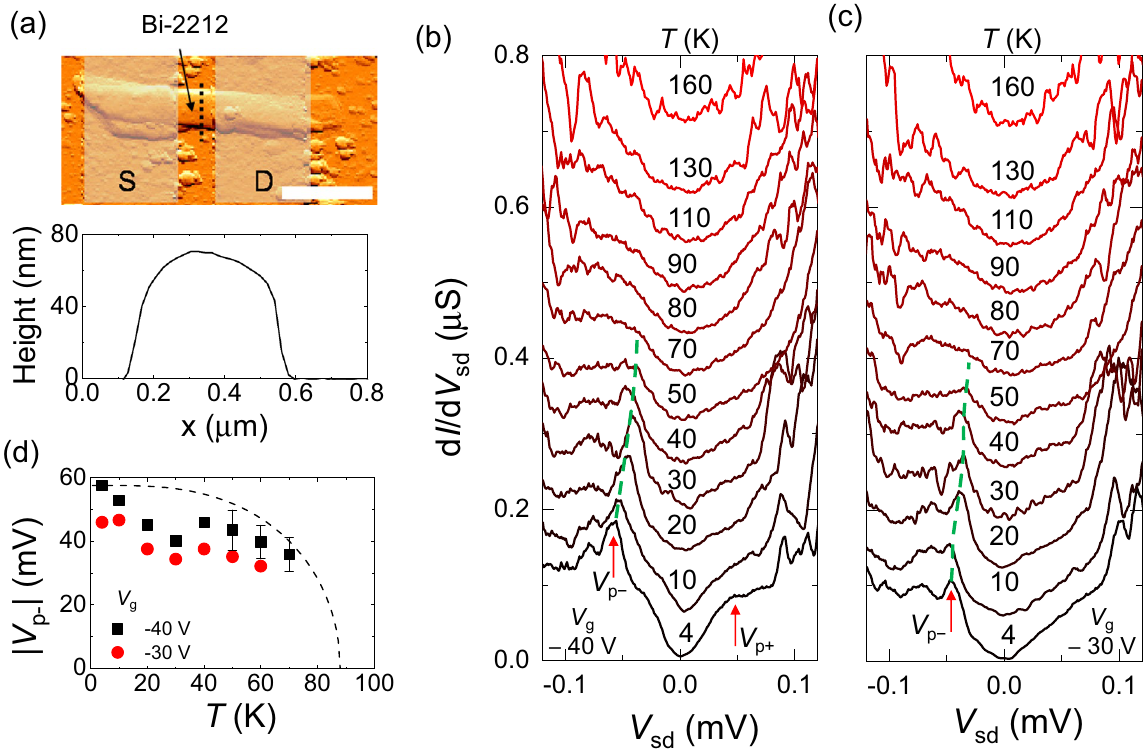
Figure 4. vdW gap tunneling spectroscopy for Bi-2212. ( a ) Upper panel: AFM image of a Bi-2212 device. Scale bar: 1 μm. Lower panel: height profile along the dashed black line in the upper panel. ( b ), ( c ) d I /d V sd as a function of V sd for various temperatures, as obtained at V g = − 40 and − 30 V, respectively. Dashed green lines follow the gap edges as T is varied. ( d ) Closed squares and circles: | V p− | as a function of T for V g = − 40 and − 30 V, respectively. Dashed curve: a plot based on Eq. (1) for